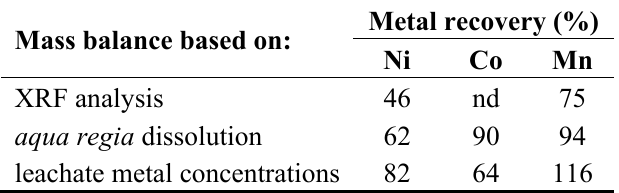
Table 2. Recovery of metals during reductive dissolution of laterite by At. ferrooxidans based on X-ray fluorescence (XRF) analysis and dissolution by aqua regia of samples of ore before and after leaching. These are compared with recovery values determined by metal concentration in the leach liquor, which are based on the elemental composition of the laterite determined by BHP Billiton (nd, not determined). Metal recovery Mass balance based on: